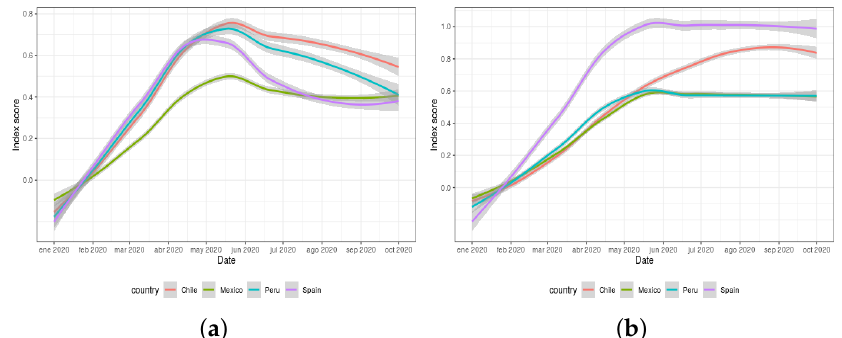
Figure 8. Response2covid19 dataset global indexes for Chile, Mexico, Peru, and Spain: ( a ) rigidity of public health index; and ( b ) economic intervention